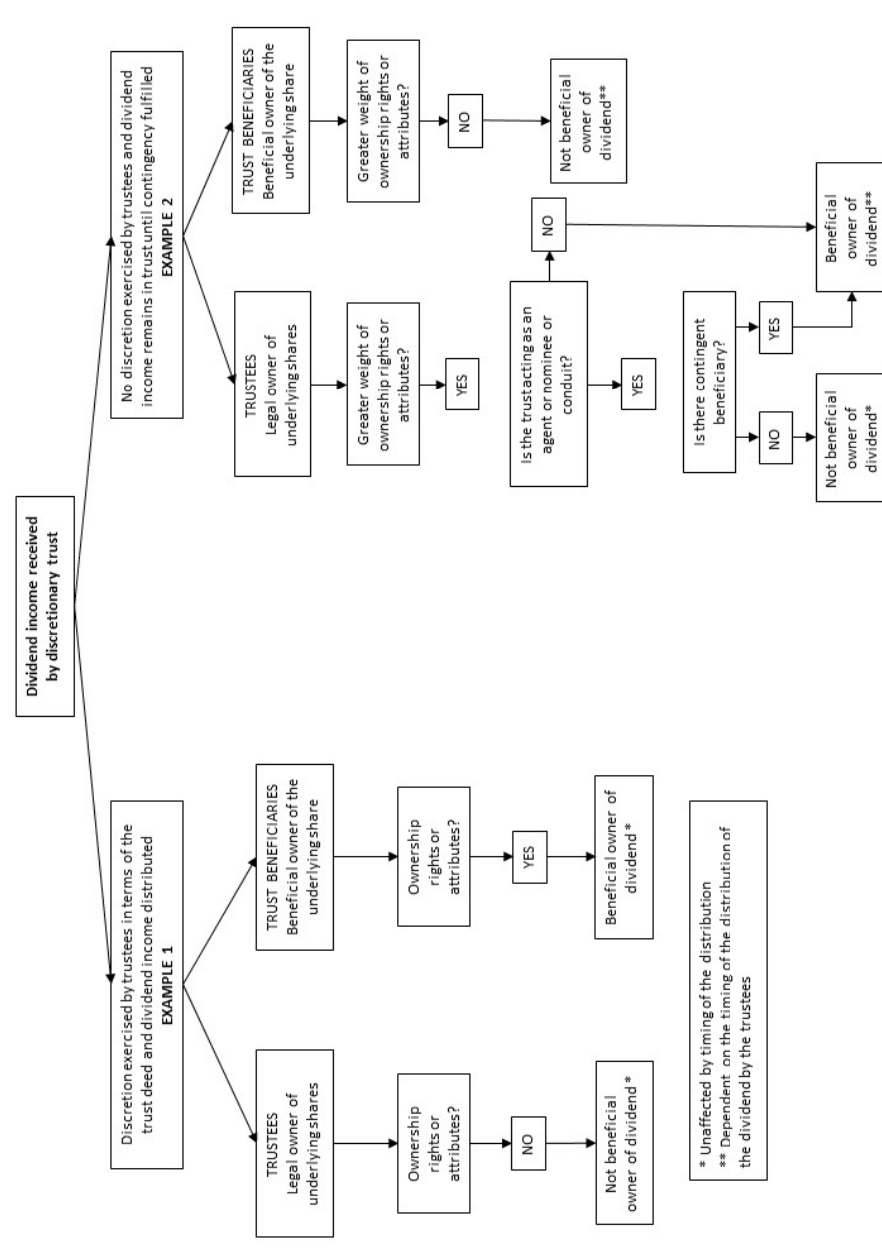
FIGURE 5: The beneficial owner of dividend income received by a discretionary trust Source: Compiled by